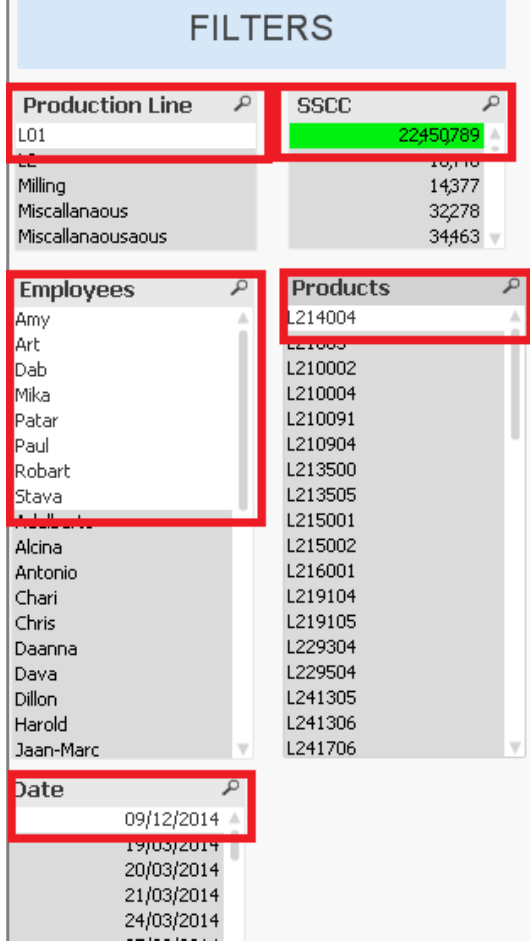
Figure 4. Unitary traceability of the product.